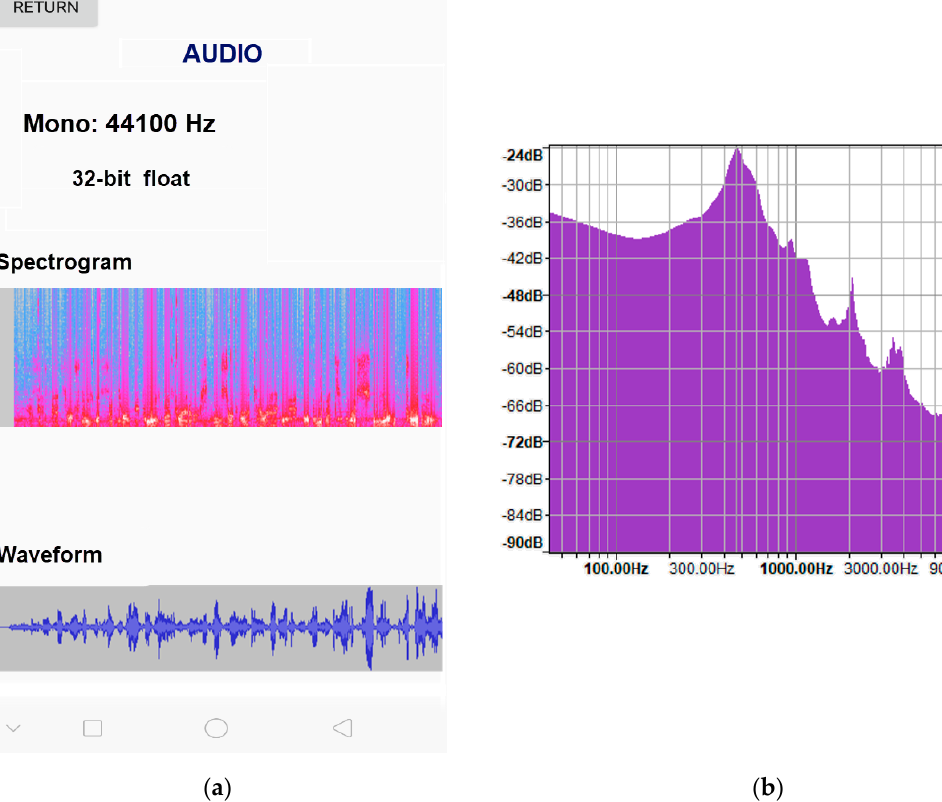
Figure 16. Audio data from GY-MAX4466 ( a ), and a spectrum plot ( b ).